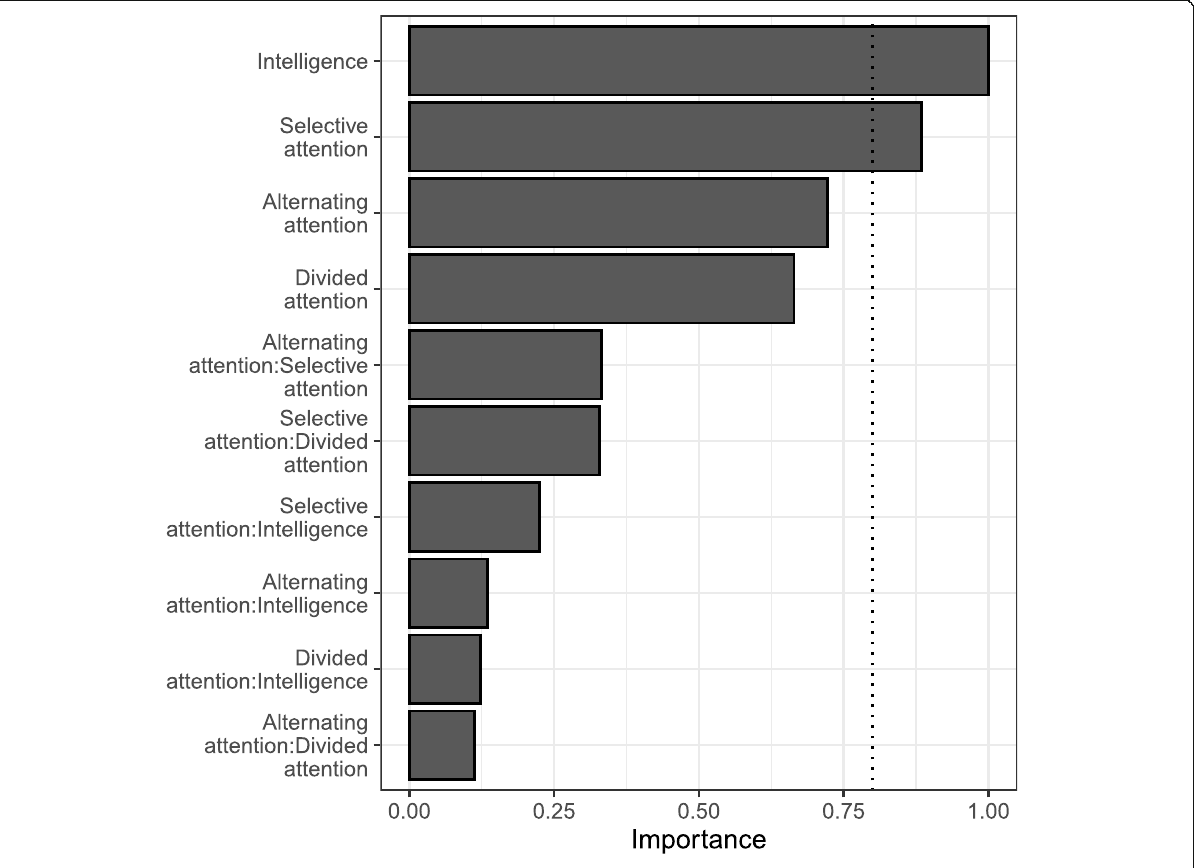
Fig. 4 Model-averaged importance of